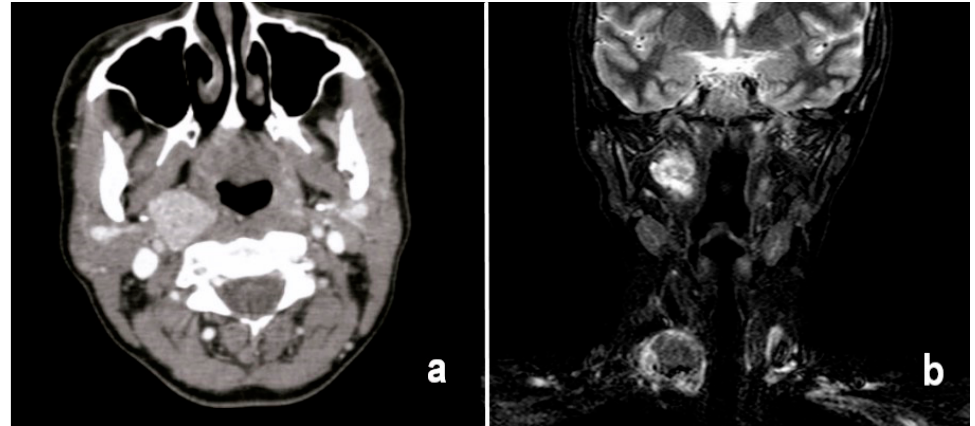
Figure 2. ( a ) Axial CT scan of the parapharyngeal node; ( b ) coronal MRI scan showing thyroid mass and parapharyngeal metastatic node.